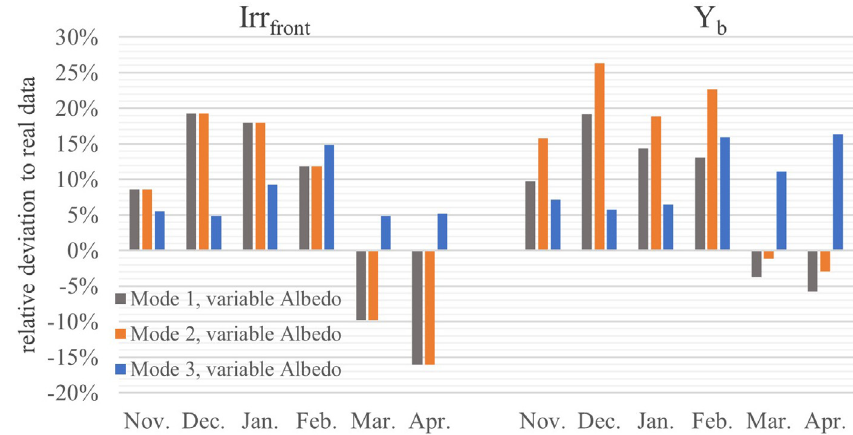
Fig. 3. This fi gure represents the simulation data using a variable albedo. The data shows a similar behaviour to the simulation using a fi xed albedo. The deviation between variable albedo and fi xed albedo is strongest in February, where mode 1 deviates 12% from the real data, whereas constant albedo only shows a 8% difference. This maximum deviation is also transferred over to the energy yield, where the delta is 10% between the 3% and 13% deviation to measurement data for fi xed and variable albedo respectively. The deviation for front irradiance simulation using variable albedo is smaller in other months, with negatives cancelling out positive values over the simulation time-frame, resulting in an average deviation of 0.9% for mode